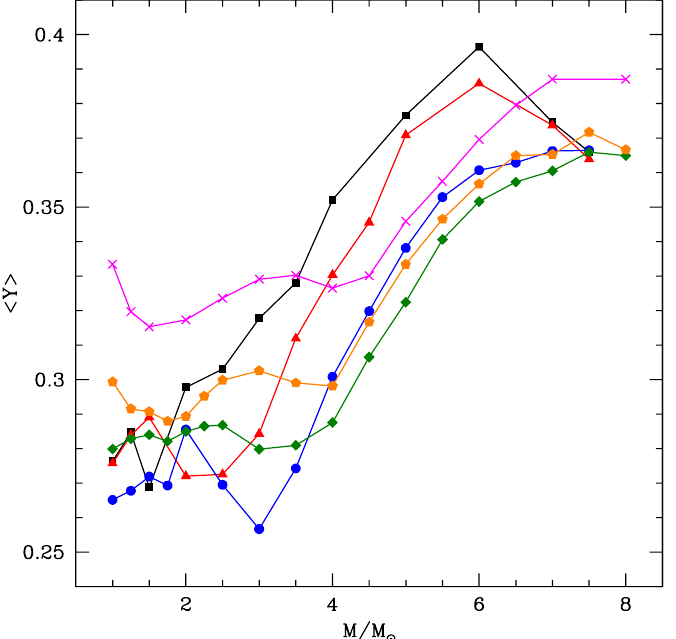
Figure 8. Average helium content of the ejecta of stars of various masses and metallicities. The average is obtained by the integral over the AGB time of the rate at which helium is lost by the star (in turn given by the product of the surface helium mass fraction and the mass loss rate of the star), normalised to the total mass lost by the star during the AGB phase. The colour coding adopted is the same as in Figure